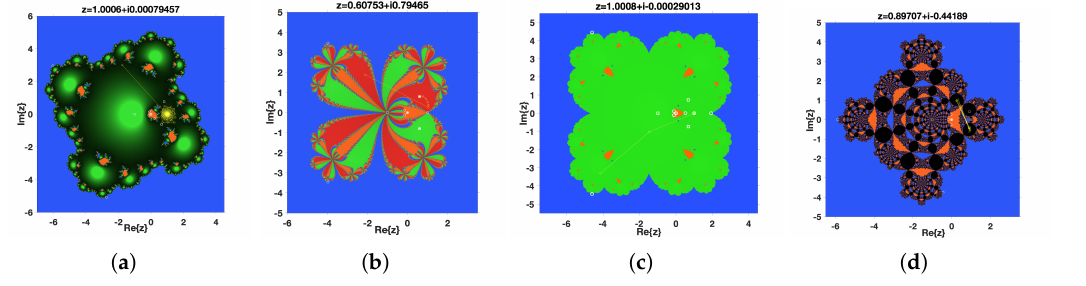
Figure 4. Dynamical planes whose behavior is unstable. ( a ) β “ ´ 200 ´ 650 i . ( b ) β “ ´ 300. ( c ) β “ ´ 700. ( d ) β “ 350.